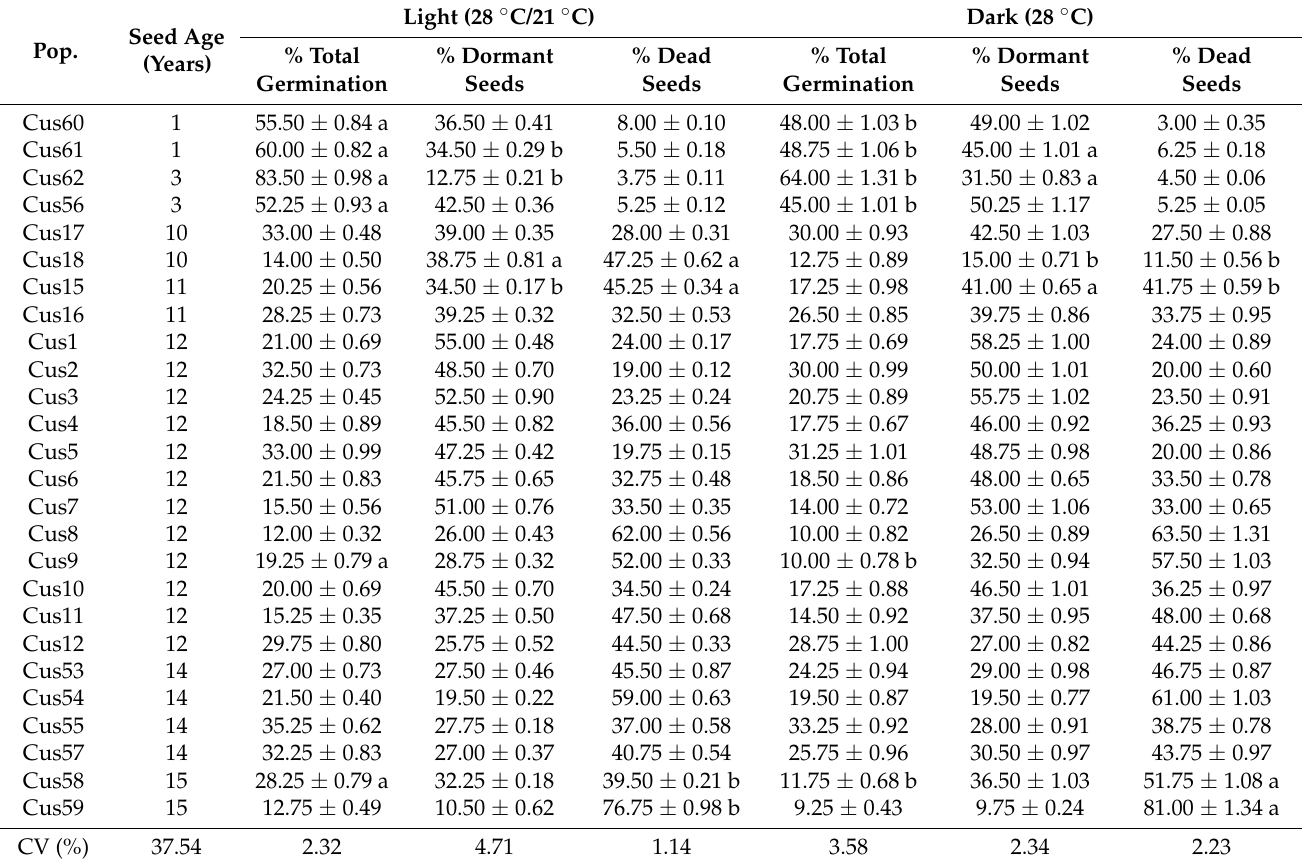
Table 4. Total percentage of germinated, dormant, and dead seeds in 26 populations of C. campestris under light treatment (day/night 28 ◦ C/21 ◦ C) and in the dark (28 ◦ C).